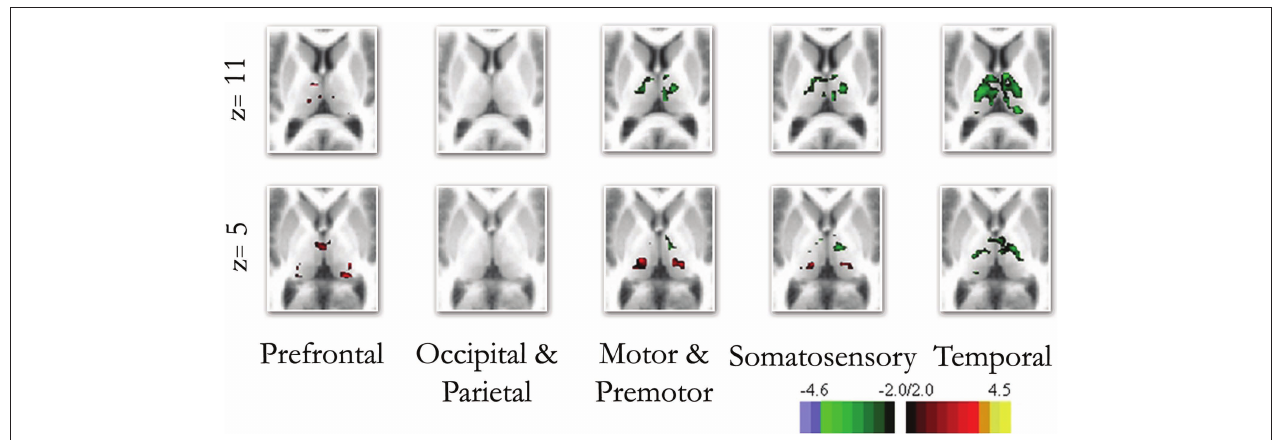
FIguRe  | Direct comparison between the end groups (i.e., children and adults). The direct comparison between children and adults confirmed many of the qualitative findings shown in Figure  . Frontal connectivity with the thalamus increases with age, and Temporal connectivity with the thalamus